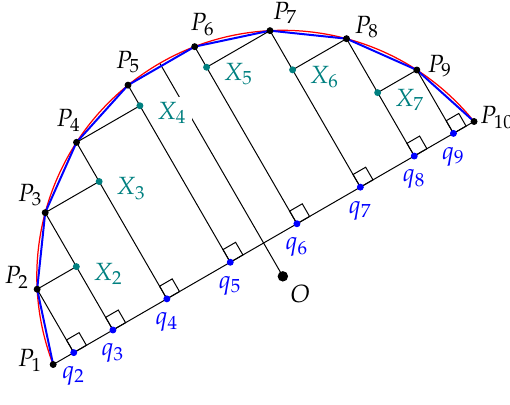
Figure 9. Inscribed length estimates for an even number of points on an